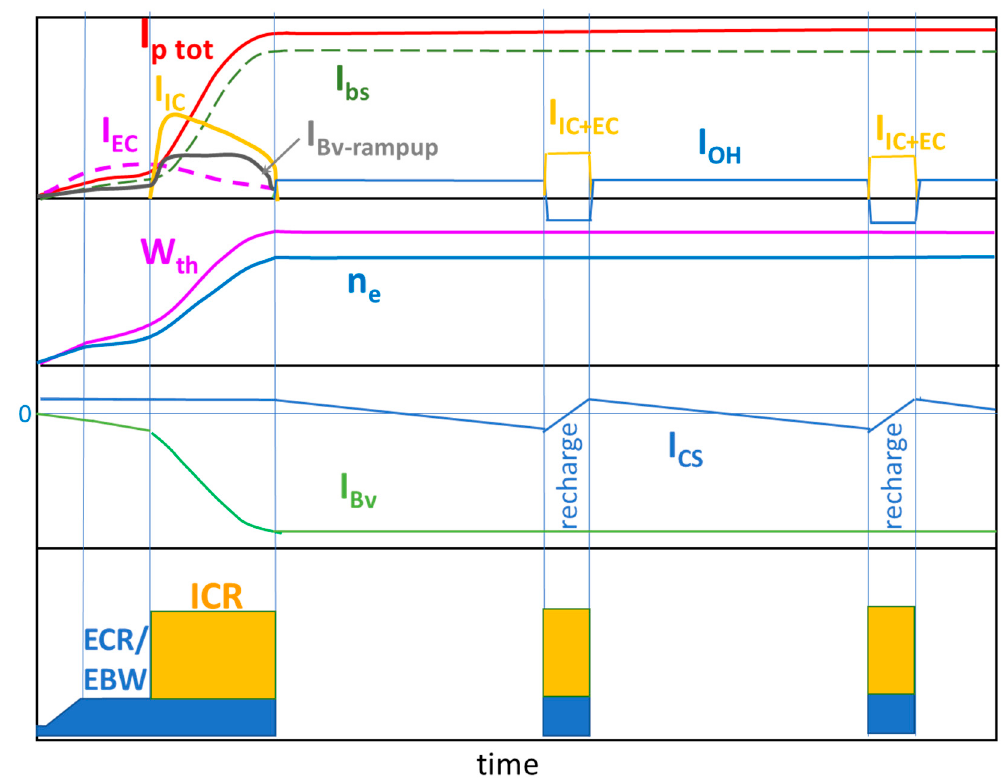
Figure 3. Proposed time sequence of the operation: I p tot —total plasma current and its components I EC , I IC , I bs , and I Bv-rampup (not to scale); W th —plasma thermal energy and n e —electron density; I CS —CS current and I BV —vertical field coil current; and auxiliary CD and heating power application periods.